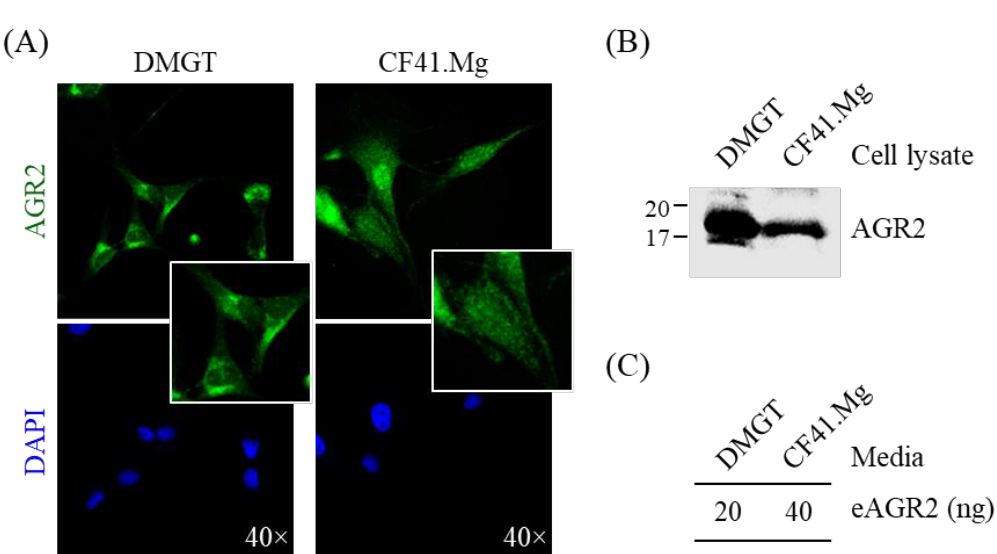
Figure 3. Detection of AGR2 expression in canine MMT cells and conditioned media. ( A ) Intracellular localization of AGR2 in canine MMT cell lines, DMGT, and CF41.Mg. AGR2 expression was verified by immunofluorescence staining using an AGR2-specific antibody. DAPI staining indicated the nuclei. Magnification, ×40. ( B ) Detection of AGR2 in cell lysates of canine MMT cell lines. Cell lysates (30 µg proteins per sample) were analyzed by immunoblotting with an AGR2-specific antibody. ( C ) Detection of extracellular AGR2 (eAGR2) in serum-free conditioned media of canine MMT cells. Cells were grown in serum-free media for one day, and the conditioned media were harvested and subsequently concentrated. The resulting conditioned media (50 µg proteins per sample) were analyzed using a competitive ELISA established for eAGR2 detection.